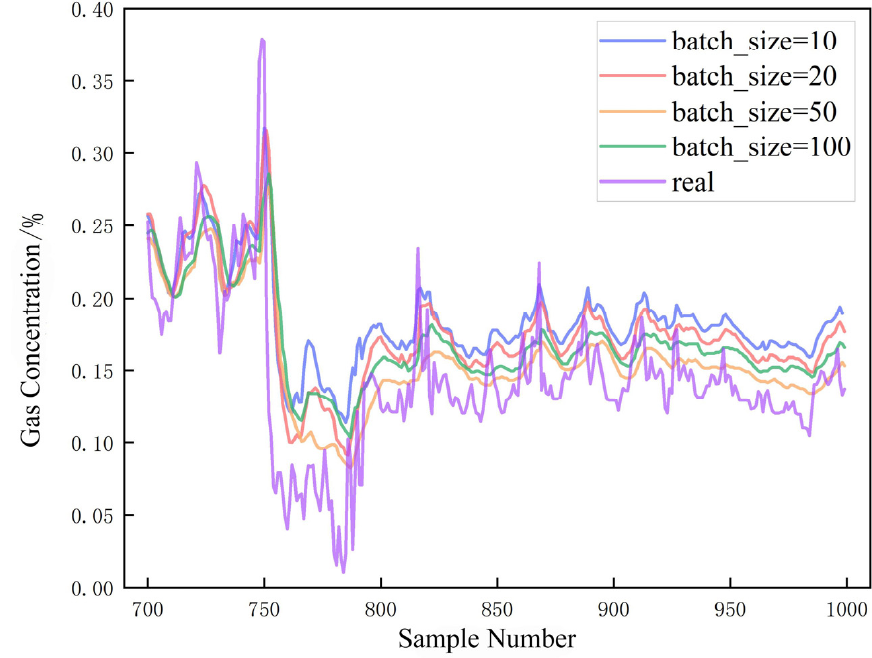
Figure 5. Comparison of batch size fitting effects. Table 2. Batch size prediction results.